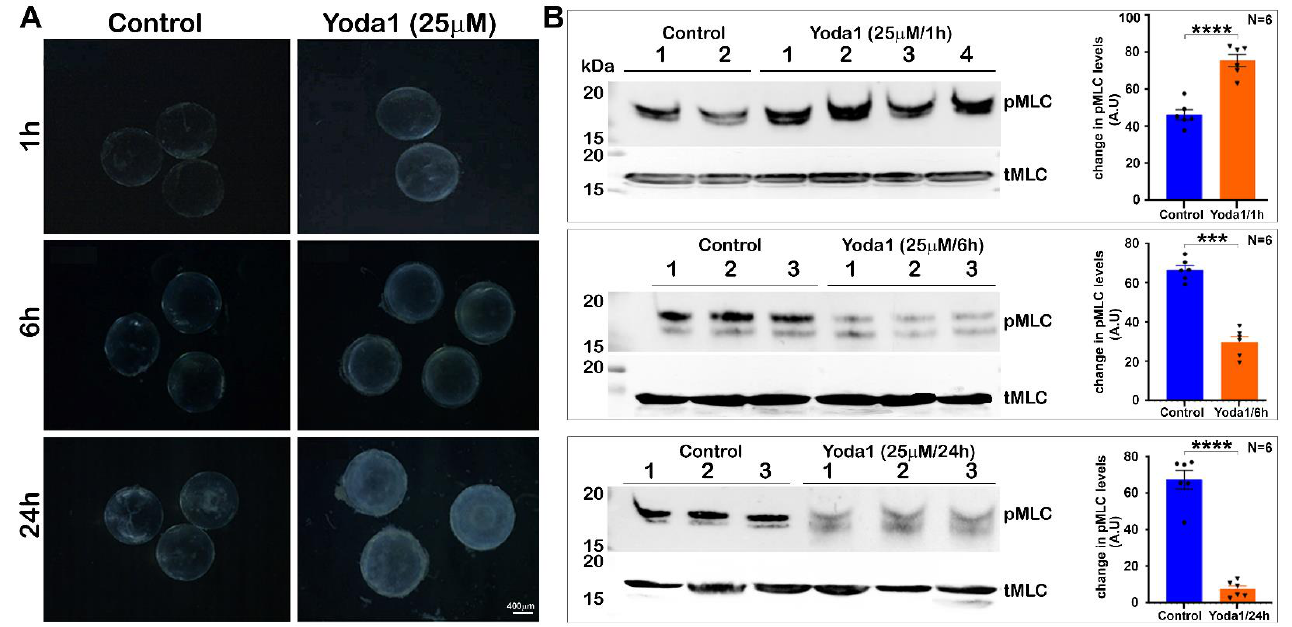
Figure 5. Piezo1 activation in ex vivo lenses by Yoda1: Effects on lens clarity and myosin II activity. ( A ) . To determine the effects of Piezo1 activation on lens transparency, lenses derived from P30 mice and maintained under culture conditions were treated with 25 µM Yoda1, an agonist of Piezo1, and changes in lens transparency were monitored for 24 h. Yoda1-treated lenses exhibited a slight haziness starting at the 1 hr interval that increased progressively with time, with lenses exhibiting significant increases in swelling and a slight nuclear opacity after 24 hrs compared to the control lenses. ( B ). In lenses treated with Yoda1 (25 µM) for 1 h, the levels of phospho-MLC were significantly elevated compared to the untreated control lenses. On the other hand, in the 6 and 24 hr Yoda1-treated lenses, there was a significant and progressive decrease in the levels of phospho-MLC (pMLC) compared to the control lenses. The levels of total MLC (tMLC), however, were found to be similar between the Yoda1-treated and control lenses throughout the course of drug treatment. Lanes 1 to 3 represent 3 experimental replicates. Bars denote image magnification. *** p < 0.001; **** p < 0.0001. A.U.: Arbitrary Units.